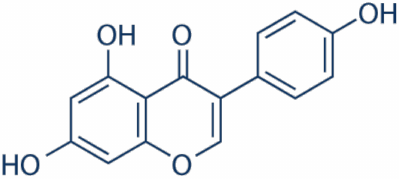
Figure 13. The chemical structure of genistein.